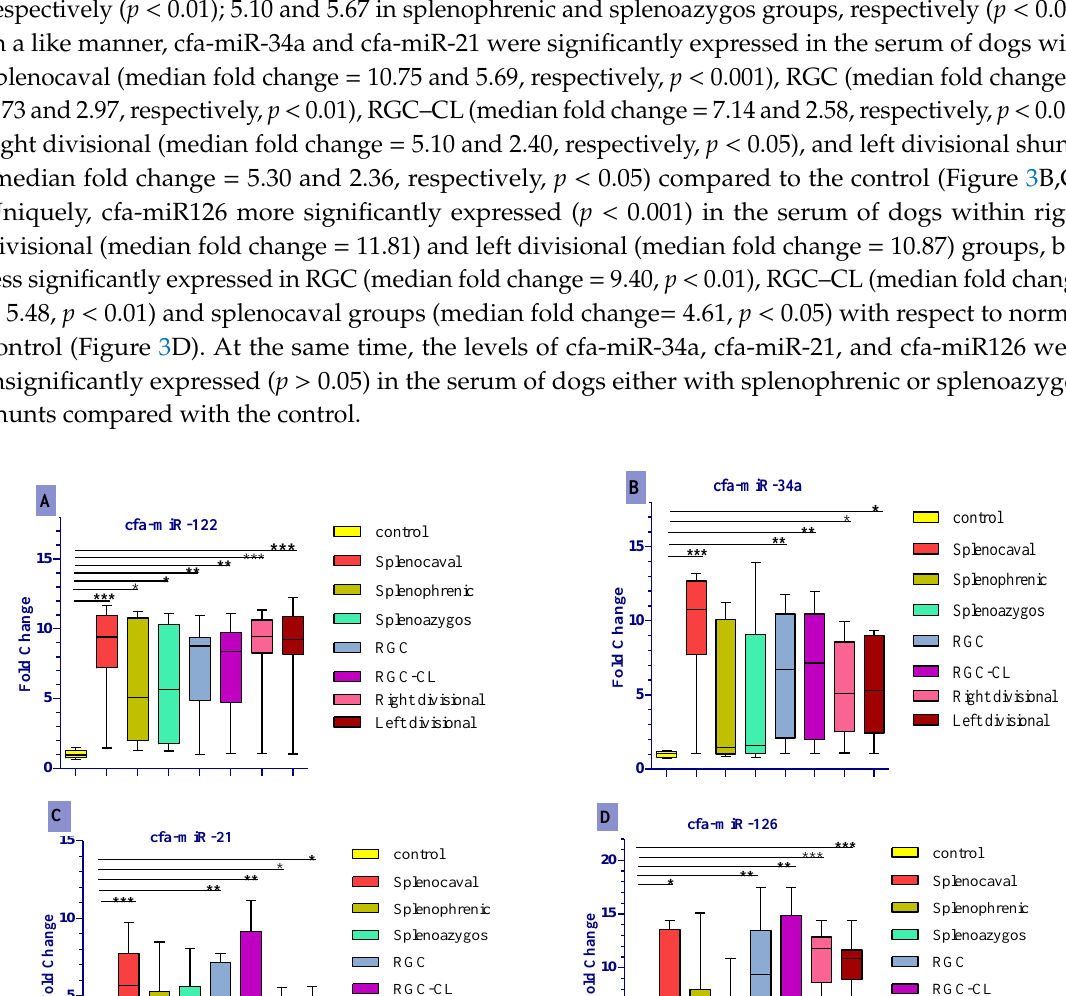
cfa-miR-126 ( D ) in serum of dogs a ff ected either with EHPSS or IHPSS as well as the healthy control Figure 3. Comparison of expression level of cfa-miR- 122 (A) , cfa-miR- 34a (B) , cfa-miR-21 (C) , cfa- 269